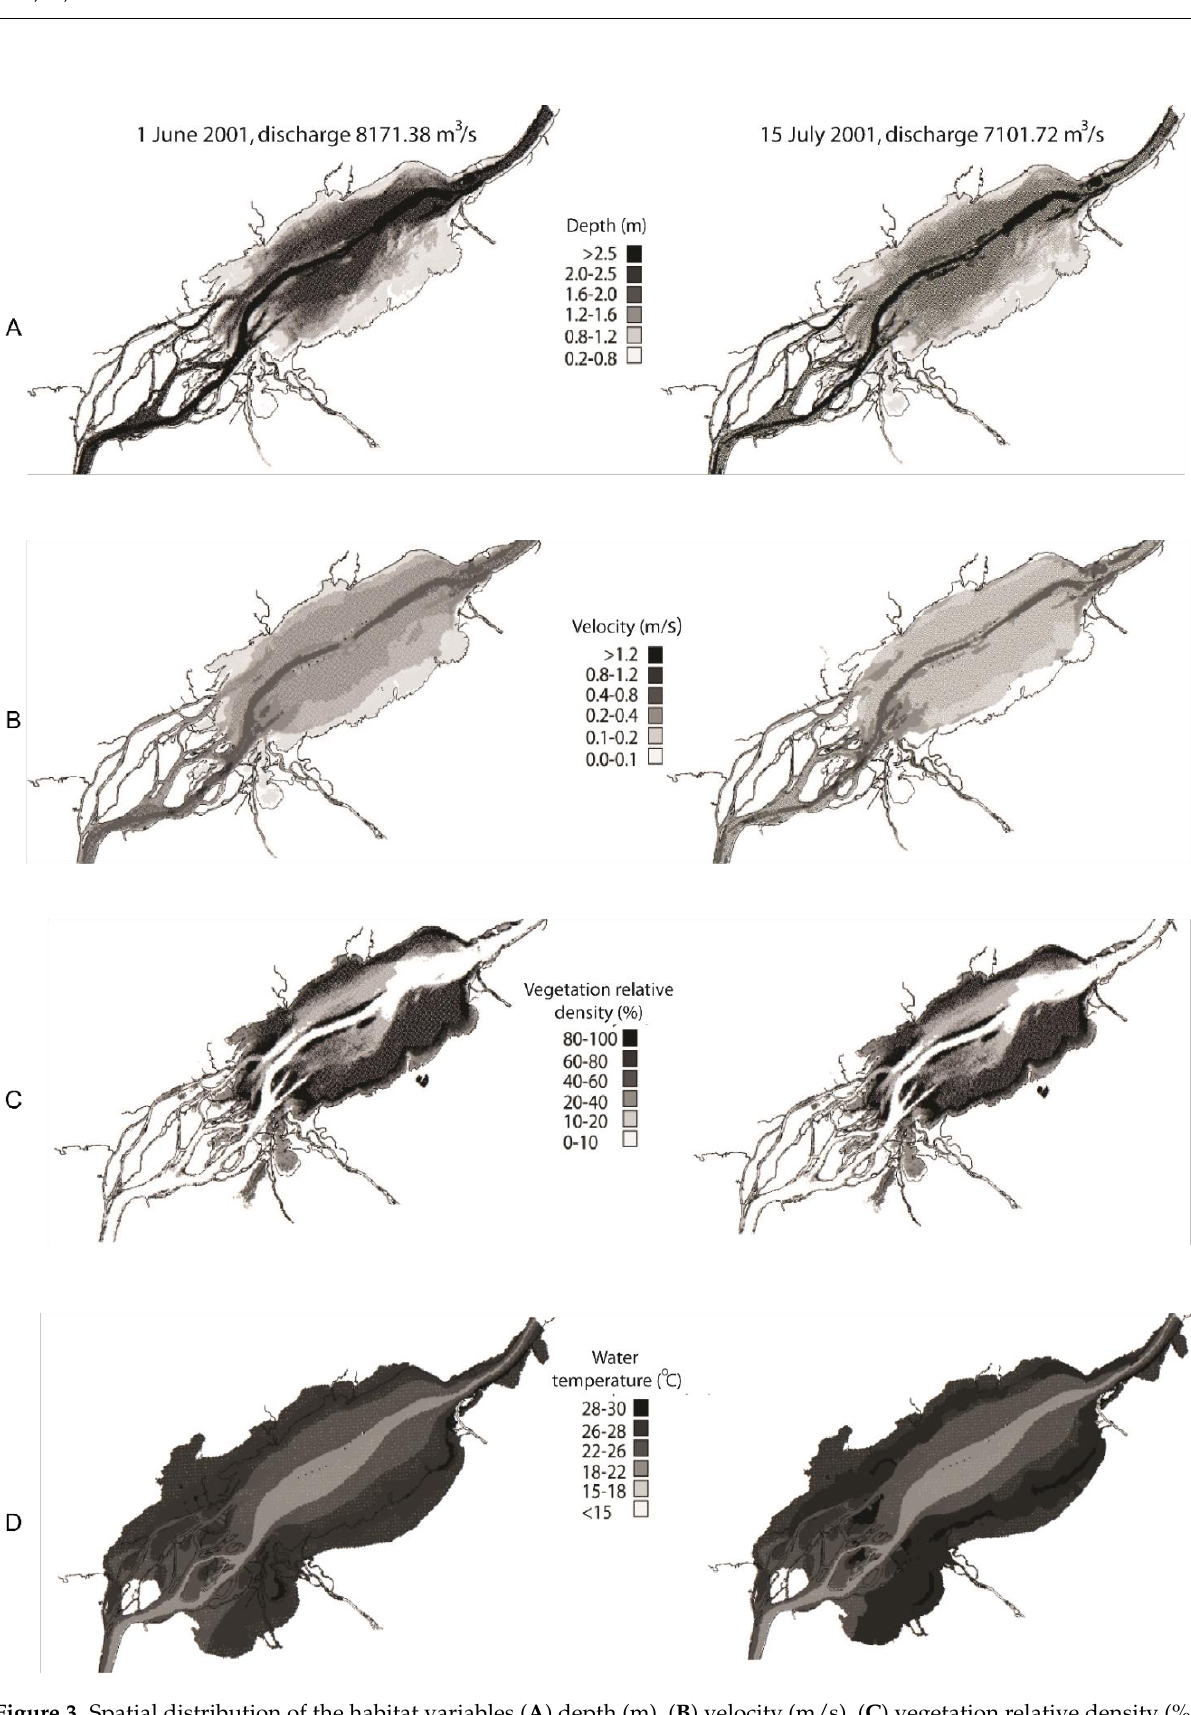
Figure 3. Spatial distribution of the habitat variables A : depth (m), B : velocity (m/s), C : vegetation relative density (%) and D : water temperature (°C), used in the model simulating carp spawning habitat in the Lake Saint-Pierre area. Two examples are presented for the year 2001: during the spawning period preceding the mortality event (1 June) and during the fish mortality (15 July).